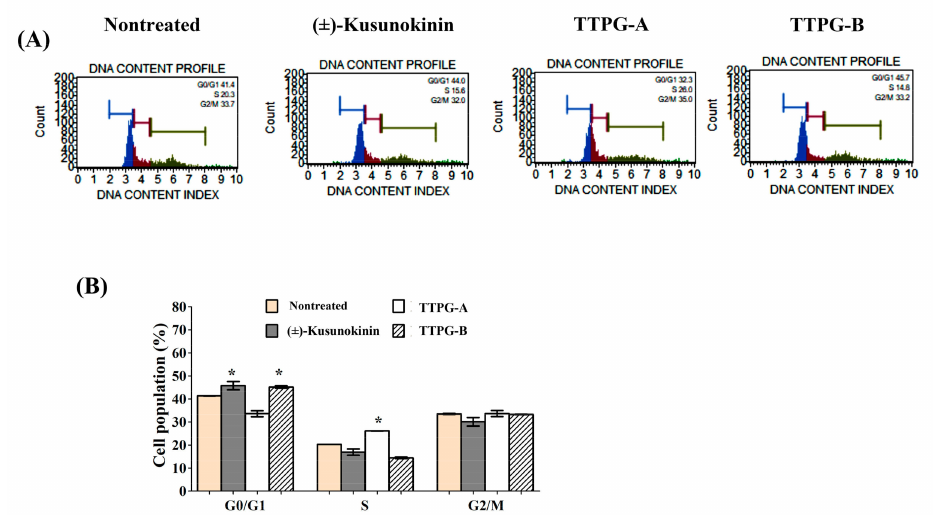
Figure 2. Induction of cell-cycle arrest by ( ± )-TTPG-A and ( ± )-TTPG-B on KKU-M213 cells. ( A ) Cells were treated with ( ± )-kusunokinin, ( ± )-TTPG-A and ( ± )-TTPG-B, at 4.47, 0.07 and 0.01 µ M respec- tively, for 48 h, while untreated cells served as control. Cell-cycle distribution was measured using flow cytometry after staining with PI. DNA histograms display cell-cycle phase of treated cells, namely G0/G1, S, and G2/M ( n = 3). The G0 phase is a resting phase, where cells leave the cycle and stop dividing. The G1 phase is the first phase within the interphase. The S phase starts when DNA synthesis commences, and completes when chromosomes have been replicated. The G2 phase is a period of protein synthesis and rapid cell-growth to prepare the cell for mitosis. The M phase is called the chromosome separation phase. ( B ) The proportion of cells according to the cell-cycle phase are presented by percentage mean ± SD ( n = 3). * Indicates p < 0.05 concerning